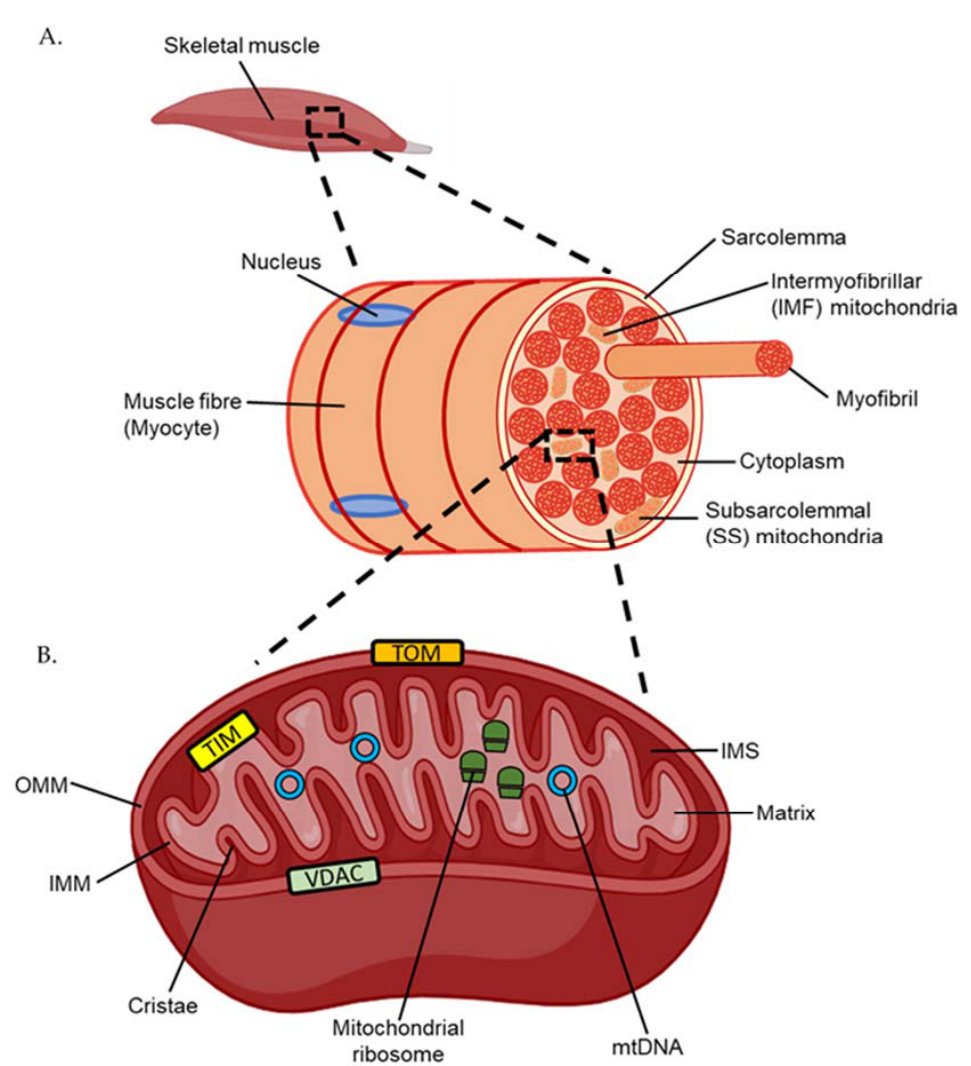
Figure 1. ( A ) Structure of a human muscle fibre or myocyte. ( B ) Structure of the mitochondria. TOM; translocase of the outer membrane. TIM; translocase of the inner membrane. VDAC; voltage ‐ dependent anion channel. IMM; inner mitochondrial membrane. IMS; inner membrane space. OMM; outer mitochondrial membrane. mtDNA; mitochondrial DNA. Unlike the nucleus, which is located only on the periphery of skeletal muscle cells, otherwise known as myocytes or muscle fibres, mitochondria exist as two morphologi ‐ cally distinct populations within skeletal muscle (Figure 1) [9,10]. Located beneath the